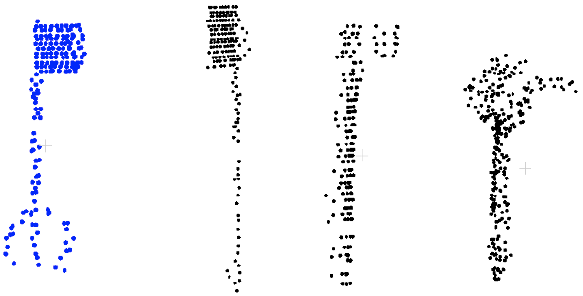
Figure 6. Real traffic sign sample (Blue) and variational synthetic samples